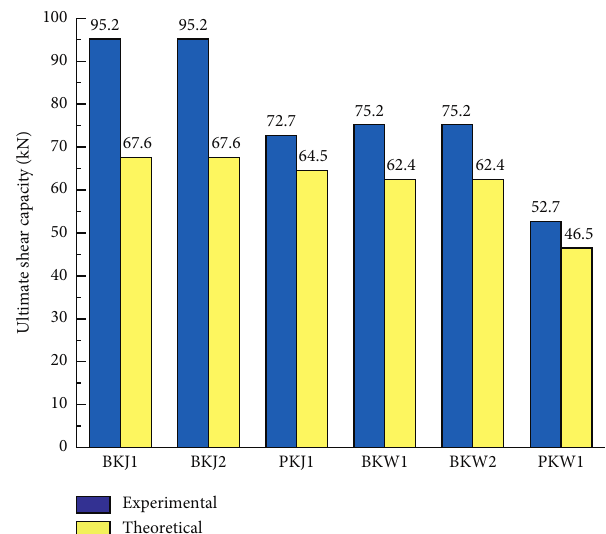
Figure 11: Comparison between experimental and theoretical ultimate shear capacity of shear